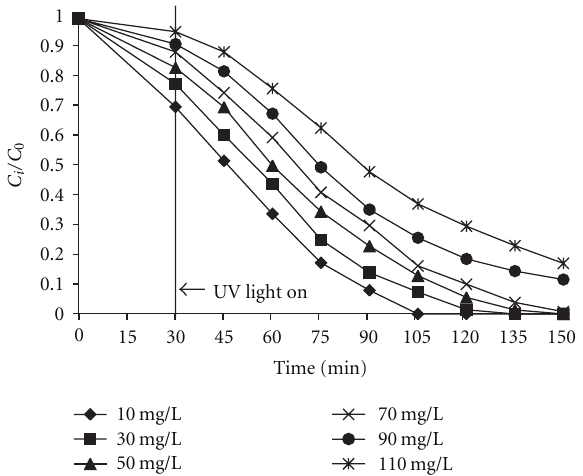
Figure 10: E ff ect of initial phenol concentration on the photo- catalytic degradation e ffi ciency. Experimental conditions: catalyst comprised TiO 2 nanotubes, silica gel, and colloidal silica in the ratio of 3 :2: 20, medium pH = 3, and air flow rate = 0.3L/min.